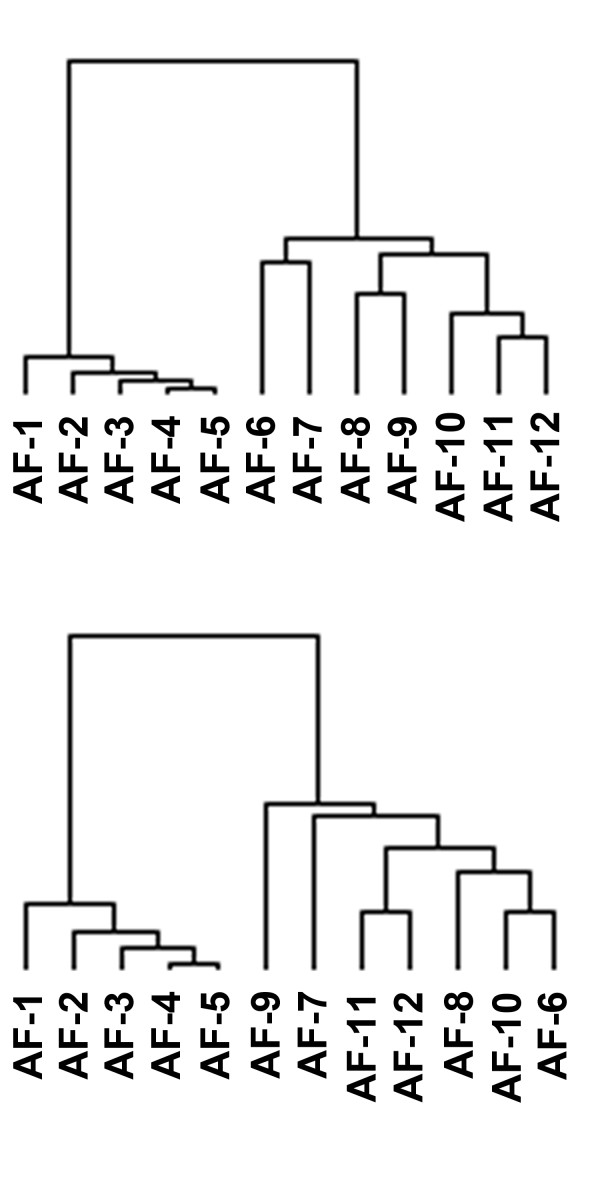
Clustering of gene expression in the aggressive fibromatosis samples using the RCC gene set (top) and OVCA gene set (bottom) and the Eisen clustering software Cluster. The 12 AF samples were clustered using the Eisen clustering software Cluster and the set of 167 gene fragments from the U_133 microarray set most differentially expressed between two groups of ccRCC previously described [11] (top) and the set of 200 gene fragments most differentially expressed between borderline and invasive OVCA [13] (bottom) as described in the text. Samples AF-1 to AF-5 formed a cluster, while samples AF-6 to AF-12 formed another cluster. The tissue samples in the tree are joined by very short branches if they have gene expression patterns that are very similar to each other, and by increasingly longer branches as their similarity decreases.